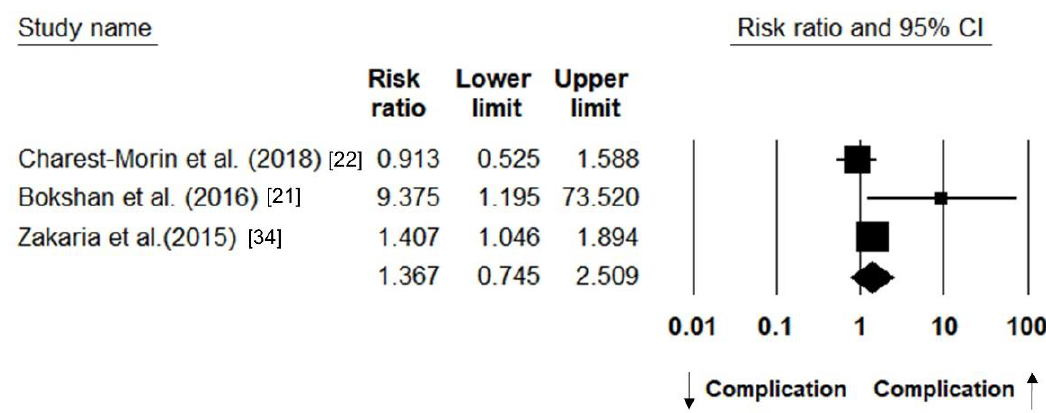
Figure 7. Forest plot of the relative risk of post-operative complications between patients with and those without sarcopenia; ↓ indicates a decrease in the risk, whereas ↑ indicates an increase in the risk.